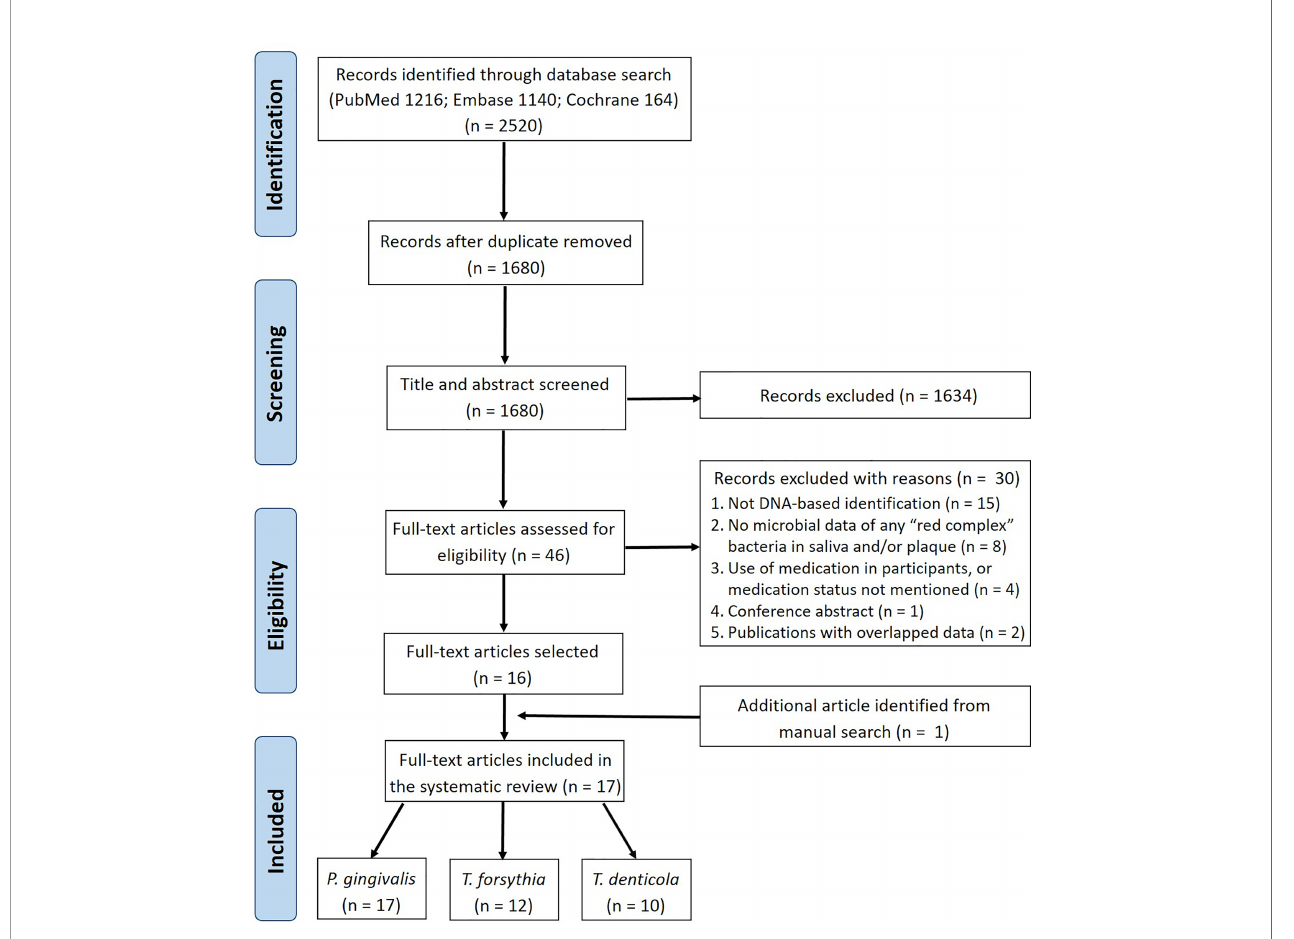
FIGURE 1 | Flow diagram of the literature search and study